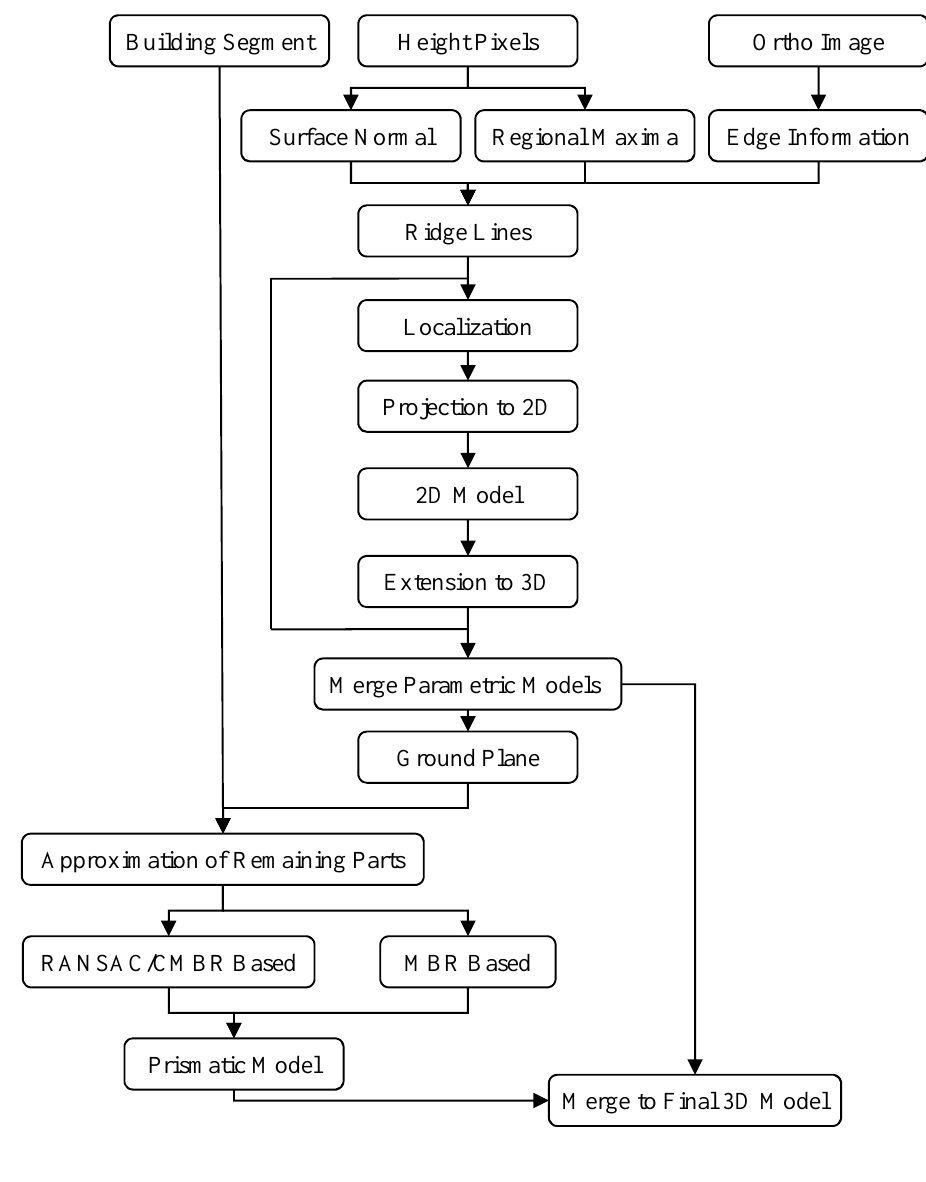
Figure 3. Workflow for projection based 3D building